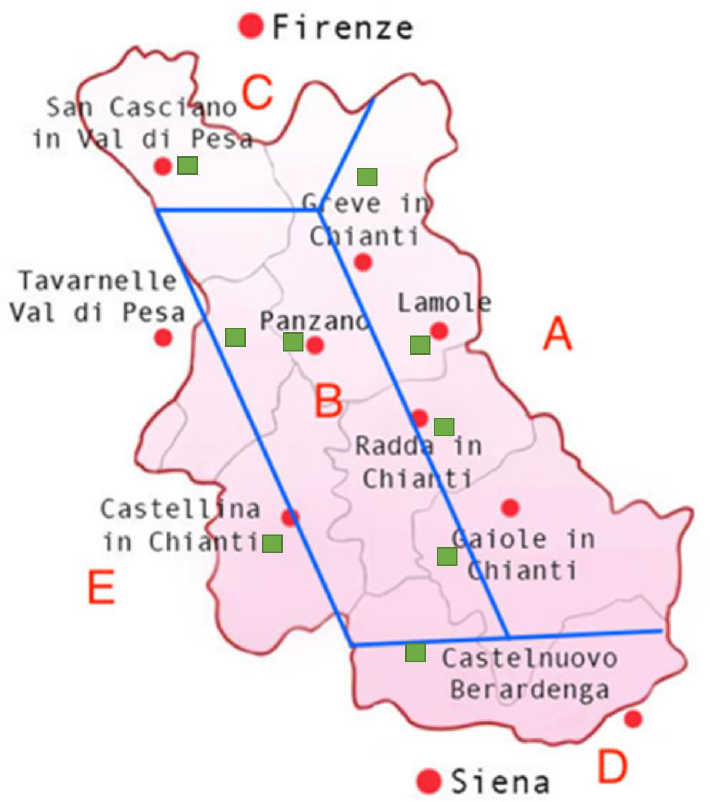
Figure 1. Topographical breakdown of Chianti Classico. The letters identify the soil composition of each area according to [21]. The approximate positions of the municipalities located within the area under examination are indicated in red. The approximate positions of the vineyards selected for the project are highlighted in green.